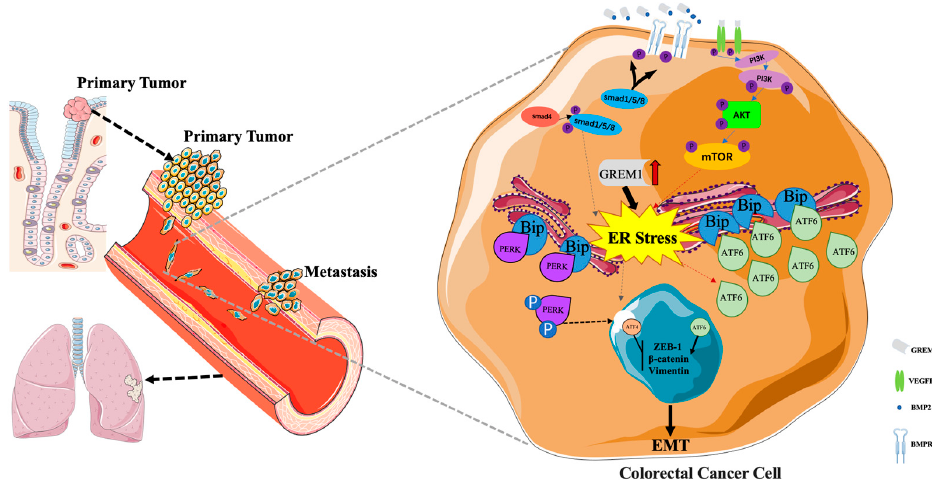
Figure 8. Mechanistic diagram of the role of GREM1 in ER stress, EMT and metastasis in CRC cells.